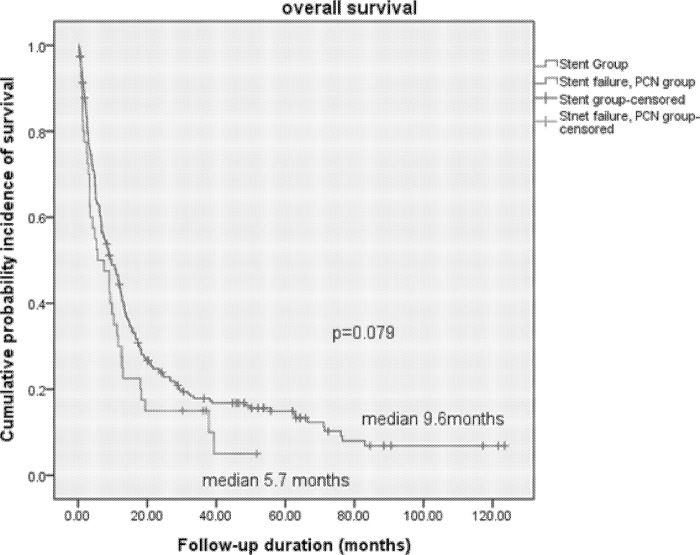
Overall survival curve between patients with retrograde ureteral stenting and percutaneous nephrostomy.